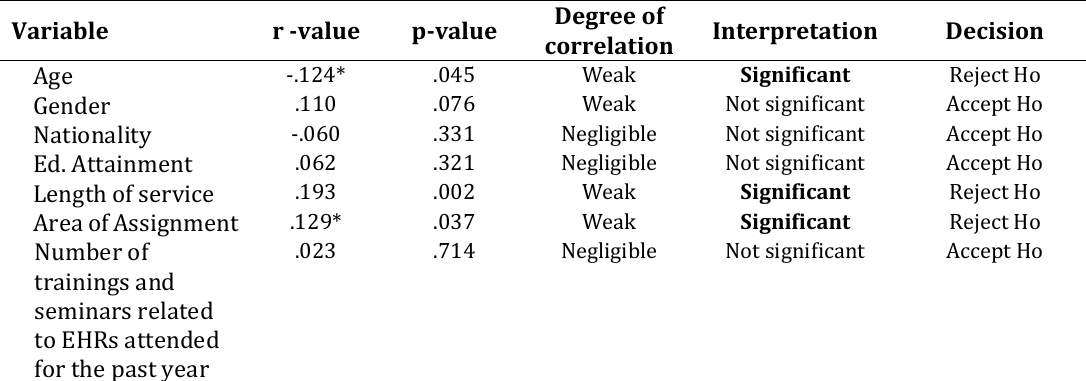
Relationship between the profile variables and skills of nurses Variable